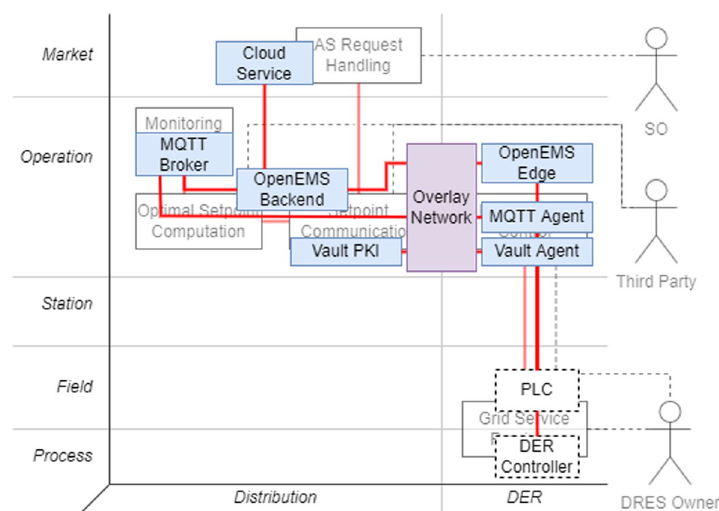
Fig. 10 Mapping of the testbed components into the SGAM